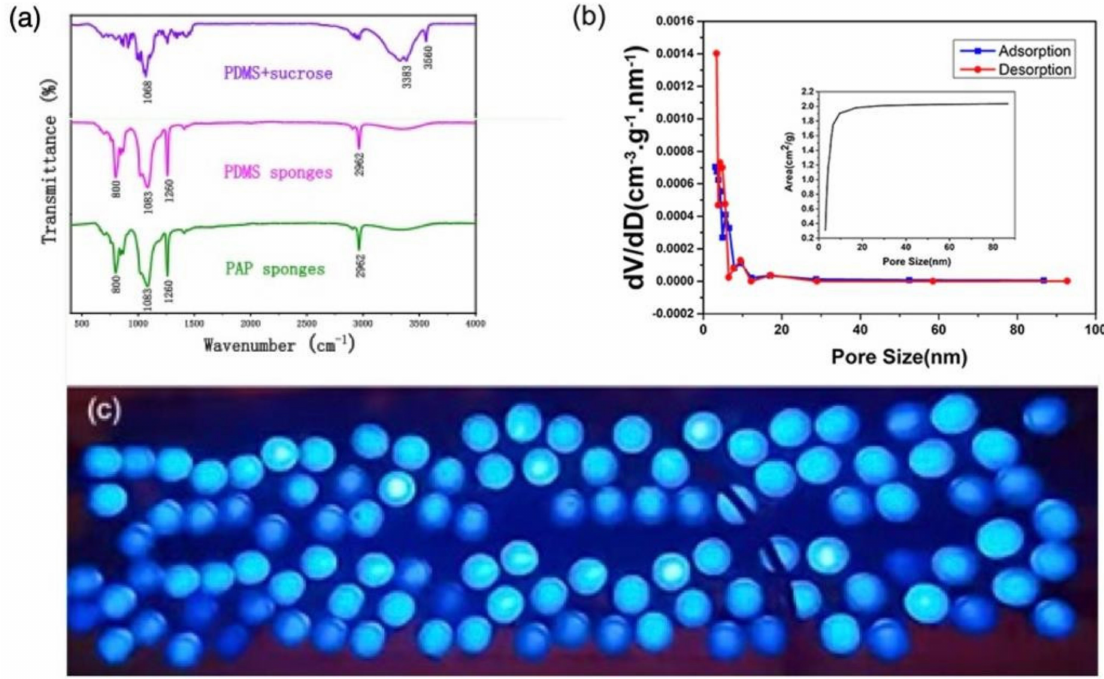
Figure 6. ( a ) Infrared spectra of PDMS + sucrose, PDMS sponges and PAP sponges; ( b ) the specific surface and porosity of PAP sponges (the illustration shows the variation in specific surface area of the PAP sponge with pore size). ( c ) 110 LED light bulbs lit up when pressed into the optimized PAP sponge capacitive pressure